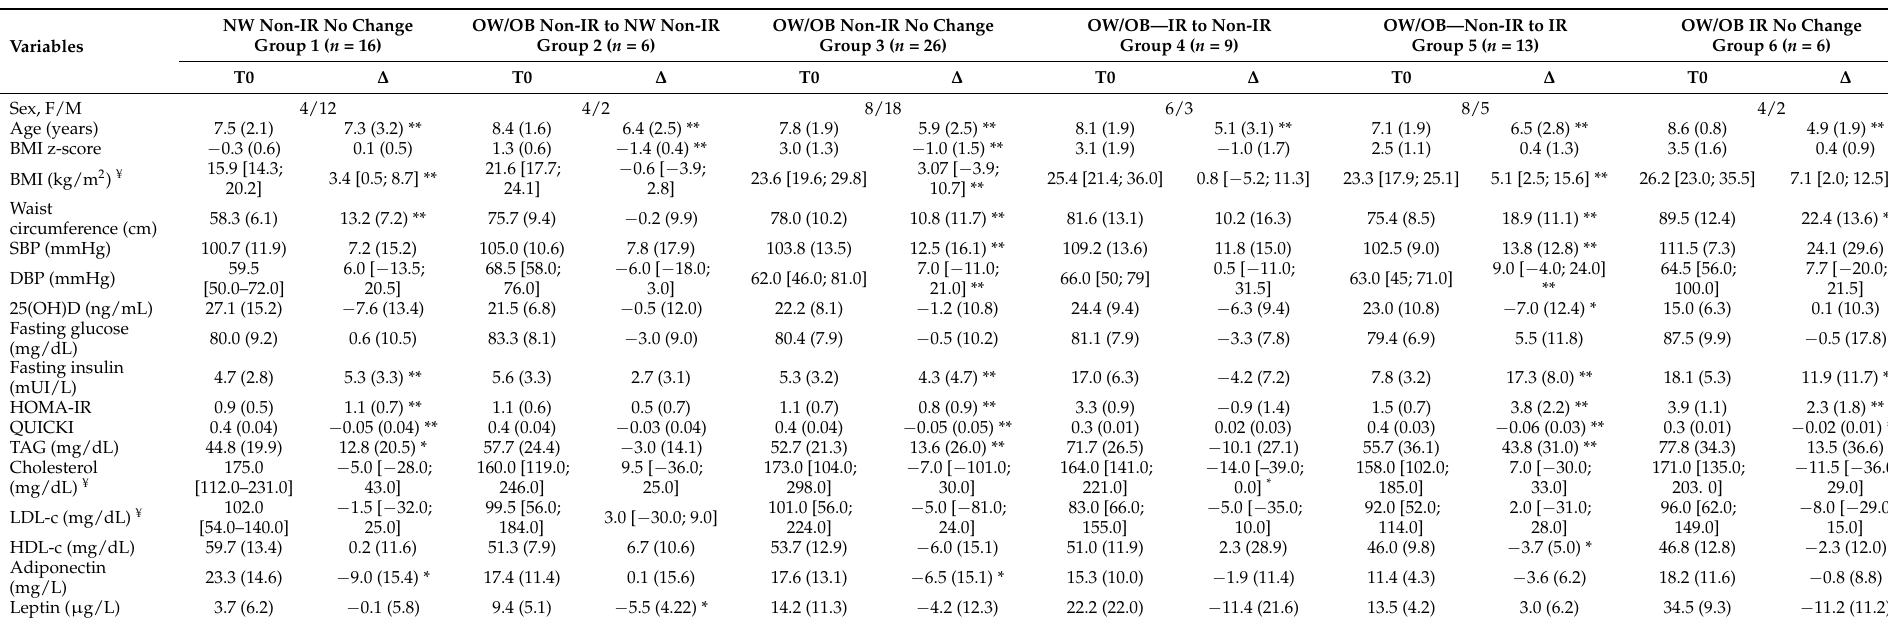
Table 4. Characteristics of the participants of the longitudinal study according to obesity degree and presence of